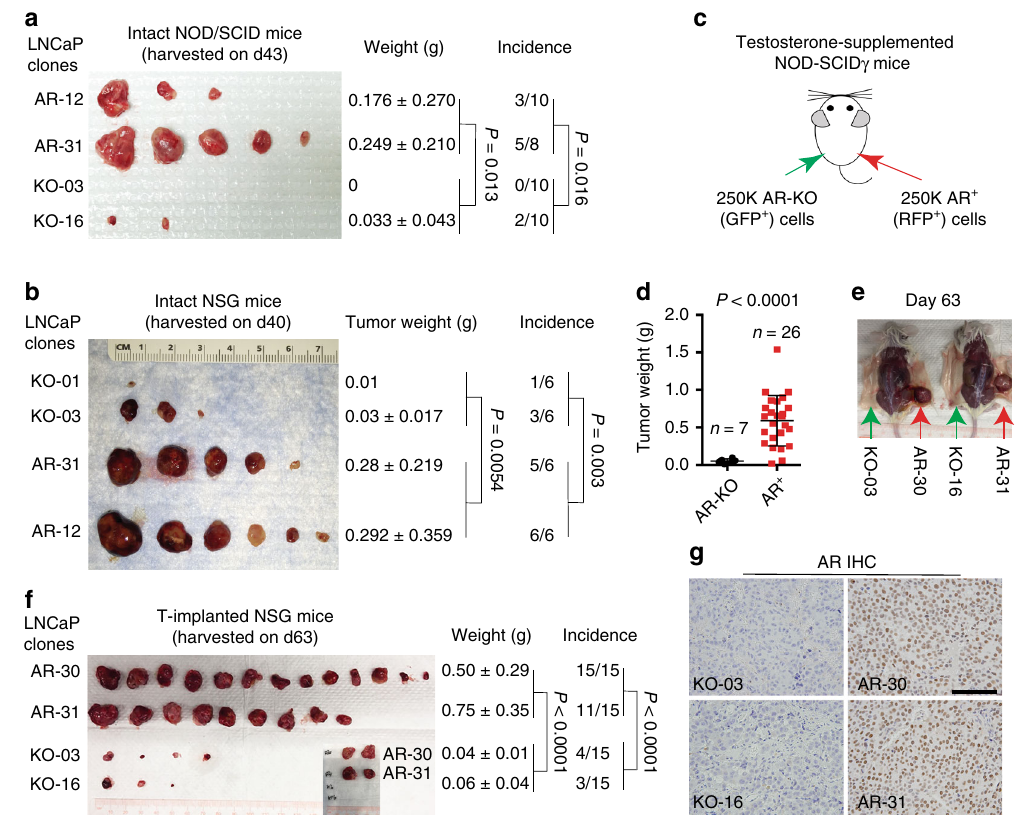
Fig. 3 AR + LNCaP cells possess higher tumor-regenerating capacities than AR-KO LNCaP cells in androgen-pro fi cient hosts. a , b AR + LNCaP cells demonstrate higher tumor-regenerating capabilities than AR-KO cells when implanted in intact NOD/SCID ( a ) or NSG ( b ) mice. Shown are clone numbers (500,000 cells for each clone per injection), endpoint tumor images, tumor weight and incidence, and P values for the pooled comparisons of tumor weight (Student ’ s t -test) and incidence ( χ 2 test). c – f AR + LNCaP cells manifest much higher tumor-regenerating activities than AR-KO cells when implanted in the same T-supplemented male NSG mouse. Shown are the experimental scheme ( c ), comparison of tumor weights ( d ; Student ’ s t -test), images of two representative tumor-bearing mice ( e ), and endpoint tumor images (inset, 4 tumors from AR-30 and AR-31 clones harvested on d56 due to large tumor sizes) with clone numbers, tumor weight and incidence, and P values indicated for the pooled comparisons of tumor weight (Student ’ s t -test) and incidence ( χ 2 test) ( f ). g Representative AR IHC images of the end-point tumors. Scale bar: 250 μ m. P -values for tumor weight and incidence comparisons were determined using unpaired Student ’ s t -test and Chi-squared test,